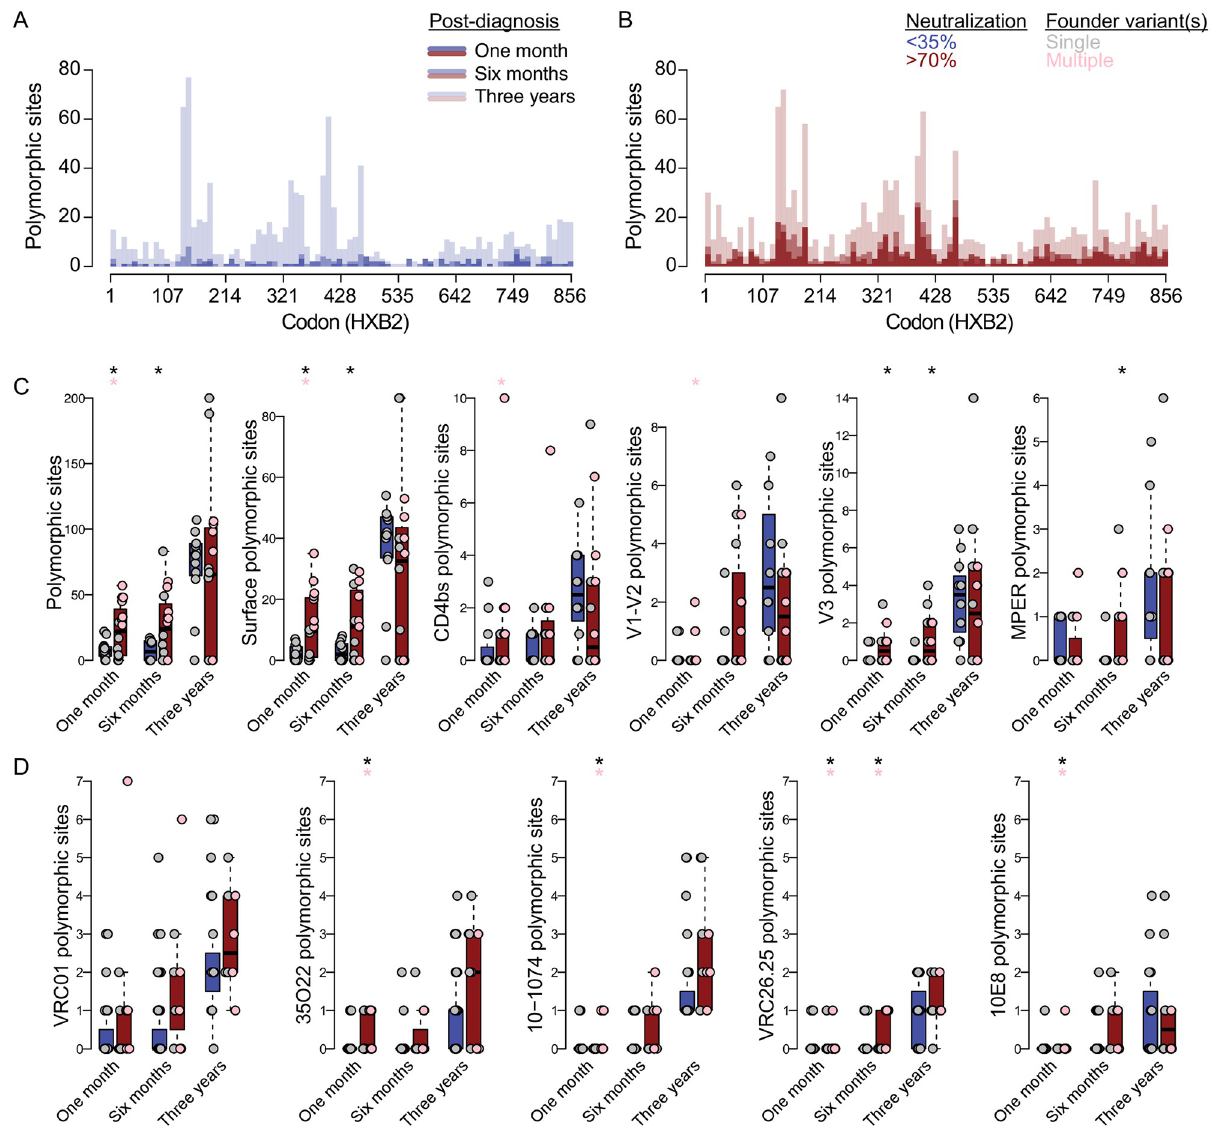
Fig 4. Multiple founders boosted diversification in broad neutralizers. Comparisons of polymorphic sites in RV217 participants who neutralized < 35% (indicated in blue) or > 70% (indicated in red) of a 34-virus panel three to four years post-diagnosis. Histogram of polymorphic sites across (A) non-broad neutralizers or (B) broad neutralizers. Boxplots of the number of polymorphic sites in non-broad (blue) and broad (red) neutralizers at one month, six months, and three years post-diagnosis, shown separately for (C) all Env sites, surface sites, CD4bs, V1-V2, V3, and MPER Ab contact sites and for (D) VRC01, 35O22, 10–1074, VRC26.25, and 10E8 epitopes. Points are shown separately for individuals infected with a single founder (grey) versus multiple founders (pink). (D) Asterisks denote significant pairwise comparisons (p � 0.05) of (C) Mann-Whitney U tests and (D) Fisher’s exact test between broad and non-broad neutralizers (black) and single- versus multiple-founder broad neutralizers (pink).